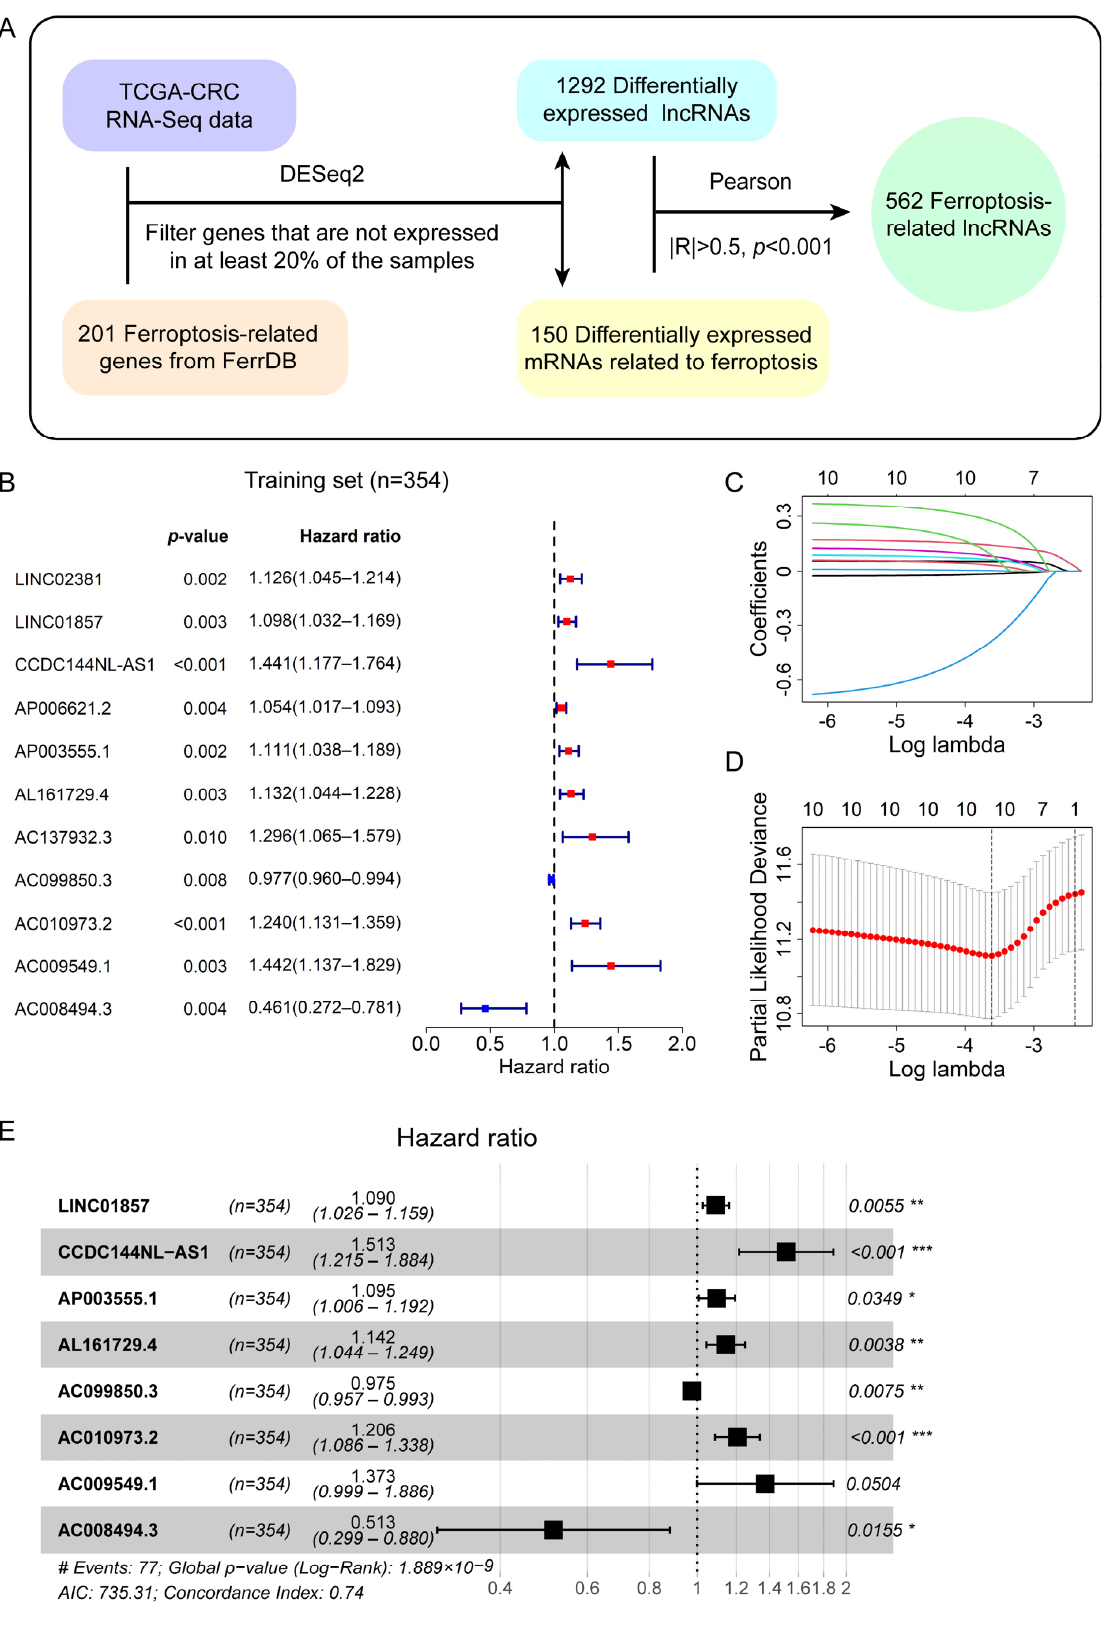
Figure 1. Construction of a prognostic signature composed of eight ferroptosis-related lncRNAs based on the training set. ( A ) Flowchart for the identification of ferroptosis-related lncRNAs. ( B )